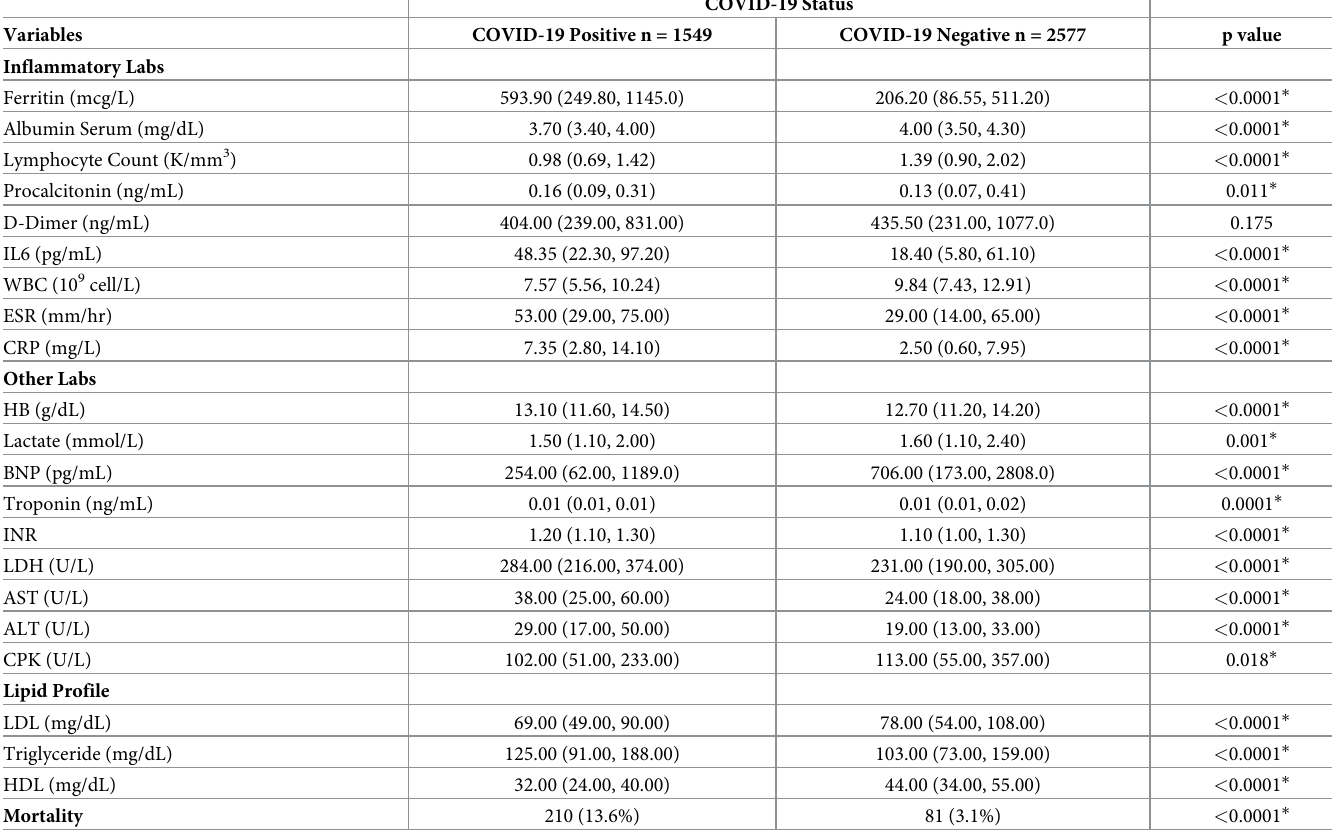
Non-hypotensive (MABP > 65) patients were stratified by tertiles of MABP. In COVID-19 (+) patients T1 MABP resulted in an average MABP of 77.5 ± 5.4 mm Hg or an average BP of 115 ± 18/68 ± 11 mm Hg; T2 MABP of 91.5 ± 3.4 mm Hg or an average BP of 127 ± 18/74 ± 11 mm Hg and T3 MABP of 108 ± 10 mm Hg or an average BP of 146 ± 24/83 ± 14 mm Hg (Table 2). T2 tertile of MABP had the lowest mortality among COVID-19 (+) patients (56/551; 10.2%) and the T1 tertile demonstrated the greatest mortality at 16.1% than T2 (p < 0.05; Table 2) (See S2 Table for unabridged variables). Mortality in T3 tertile of MABP did not differ from T2. No difference in mortality was noted across the MABP tertiles of COVID-19 (-) cohort (S3 Table). A MV regression model to identify the variables predicting the T1 tertile of MABP was studied. T1 tertile of MABP was compared to T2 MABP as the reference cohort since T2 MABP had the lowest mortality. In the T1 vs T2 analysis, death (odds ratio (OR) 1.709 [CI 1.123, 2.601],) and higher white blood cell count (OR 1.032 [CI 1.005, 1.183]) was associated with T1 MABP vs T2 at presentation (as shown in Fig 1). On the other hand, a higher first calcium (OR 0.769 [CI 0.597,0.992]), higher hemaglobin (OR 0.905 [CI 0.844, 0.971]), and use of enoxaparin (OR 0.743 [CI 0.554, 0.997]) were associated with T2 MABP (shown in Fig 1). The multivariate analysis informs us about the characteristics of those patients with T1 or T2 level of MABP at initial